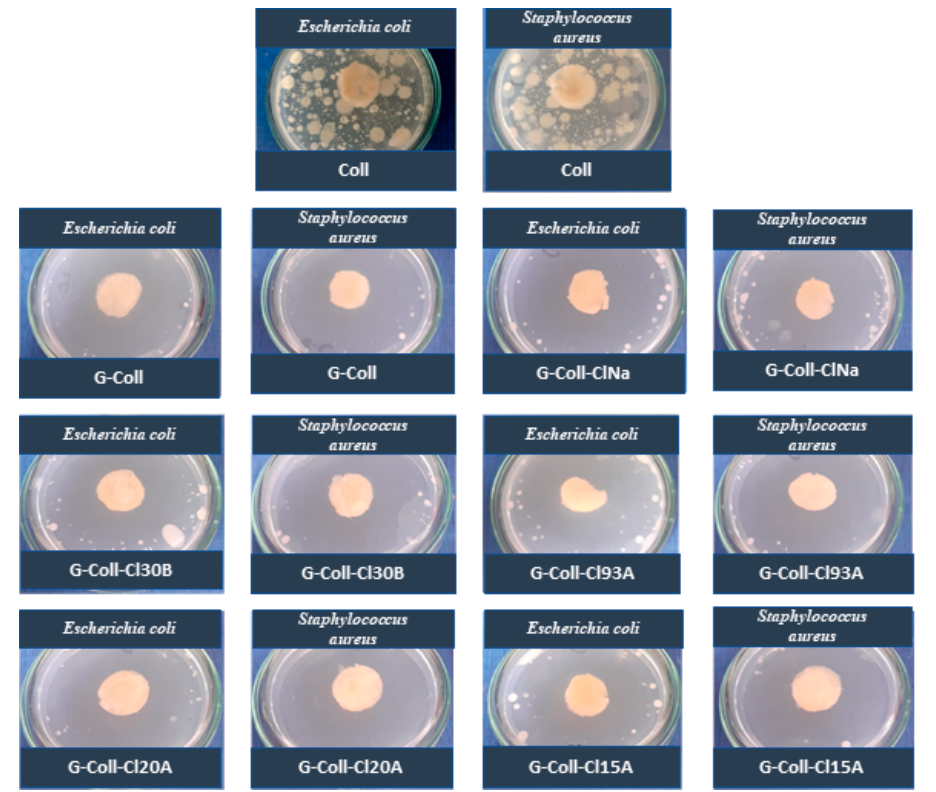
Figure 10. Antimicrobial activity against Escherichia coli and Staphylococcus aureus.